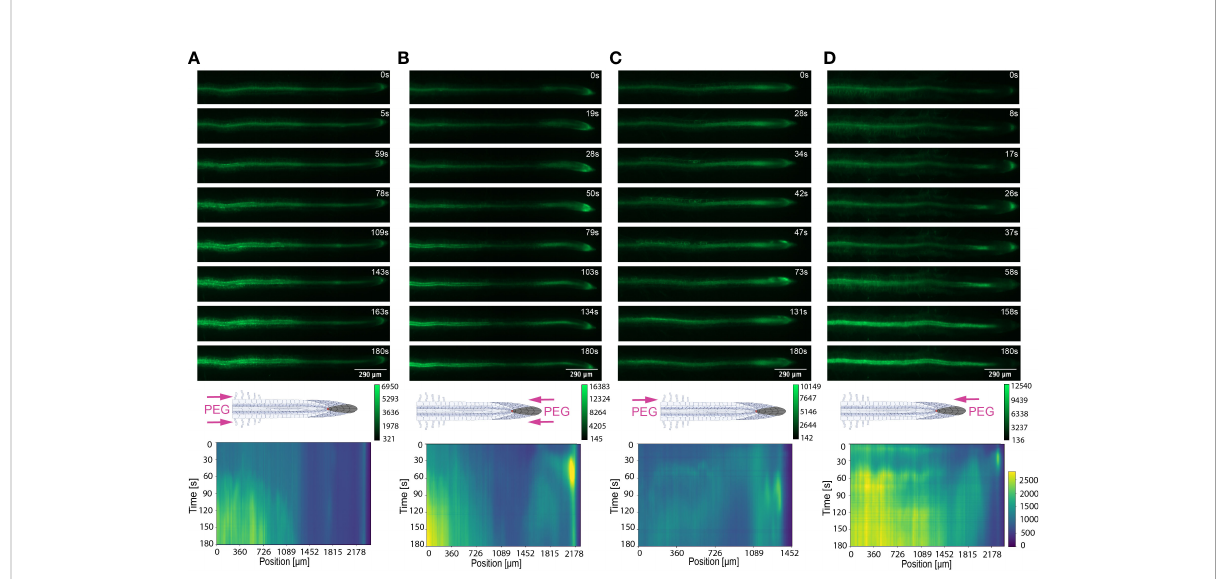
FIGURE 6 Key Ca 2+ signal localisation in Arabidopsis roots exposed to 20% PEG. Schematic diagrams depict treatment localisation and orientation at the root within the bi-dfRC with fl uorescent intensity calibration bars. Kymographs depict the spatial fl uorescense of GFP corresponding to Ca 2+ in the root over time, in dependence of treatment orientation and localisation. GFP fl uorescence in kymographs is color coded, ranging from dark blue to yellow (normalized for all samples). (A) Key Ca 2+ localisation pattern upon PEG treatment through inlets A & B of the bi-dfRC at the differentiation zone. (B) Key Ca 2+ localisation pattern upon PEG treatment through inlets C & D of the bi-dfRC at the tip. (C) Key Ca 2+ localisation pattern upon PEG treatment through inlet B (top) and control treatment through inlet A (base) of the bi-dfRC at the differentiation zone. (D) Key Ca 2+ localisation pattern upon PEG treatment through inlet D (top) and control treatment through inlet C (base) of the bi-dfRC at the